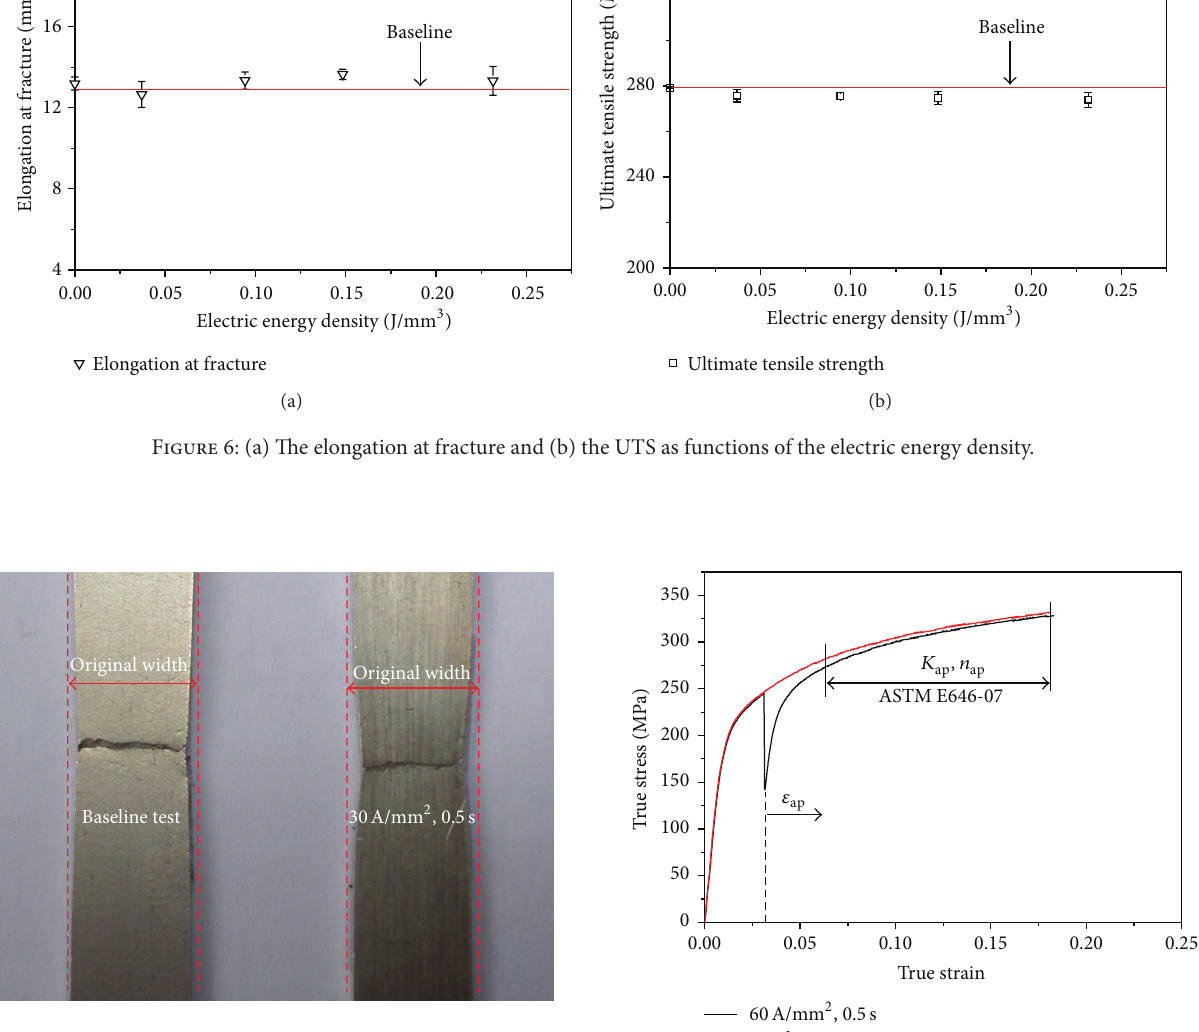
Figure 7: Intensified diffuse necking with a single pulse of electric current in plastic region. Note that the electric parameter set, 𝜌 𝑖 𝑜 = 30 A/mm 2 and 𝑡 𝑑 =0.5 sec,inducesthelowestelectricenergydensity among the electric pulse parameter sets selected in the present study.